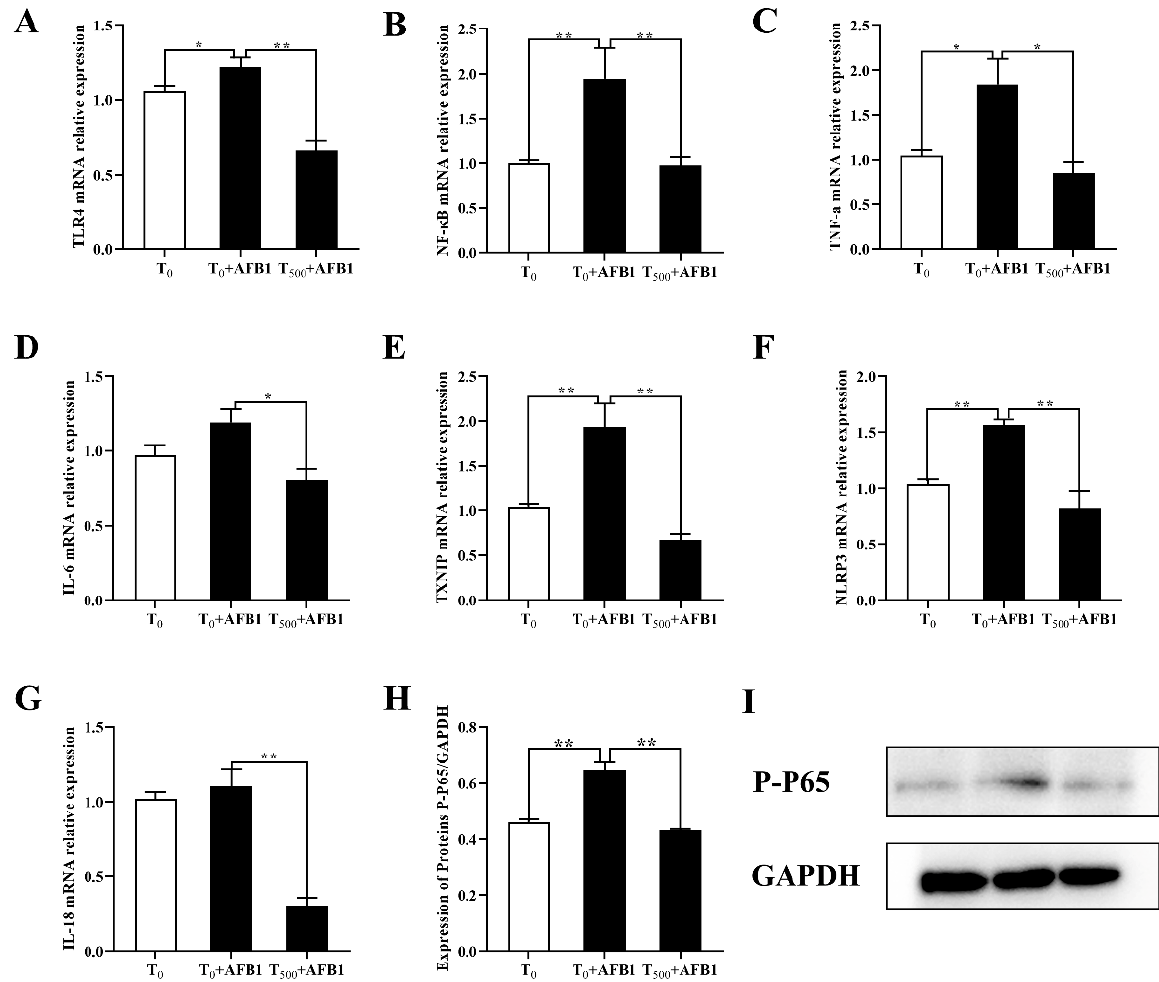
Figure 5. mRNA and protein levels of genes related to NF- κ B signaling pathway in the ileum of ducks ( Anas PlatyrhynchosI ) exposed to AFB1 at 70 days. T 0 : the control group, T 0 + AFB1: AFB1 group; T 500 + AFB1: curcumin + AFB1 group. TLR4, toll like reporter 4 ( A ); NF-kB, Nuclear factor kB ( B ); TNF- α , Tumor Necrosis Factor- α ( C ); Il-6, Interleukin -6 ( D ); TXNIP, thioredoxin interacting protein ( E ); NLRP3, NOD-like receptor family pyrin domain containing protein 3 ( F ); Il-18, Interleukin -18; P-P 65 ( G ), Phospho-NF- κ B p65 (Ser276) rabbit polyclonal antibody ( H ); ( I ) GAPDH, Glyceraldehyde-3- phosphate dehydrogenase. The relative expression of P-P65 protein in the ileum was expressed as the ratio of band intensitiy of the target protein to the internal reference (GAPDH). Values were expressed as Mean ± SEM ( n = 15), and * means p < 0.05, ** means p < 0.01.